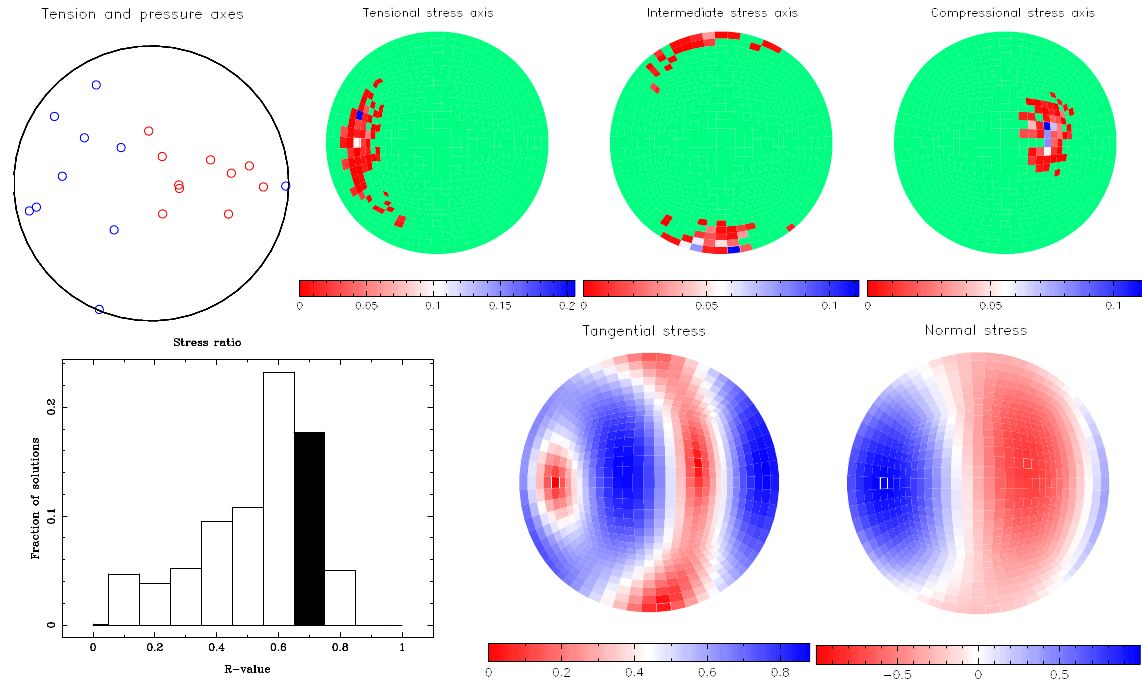
Fig. A3. Results of stress inversion for cluster of shallow earthquakes in the Iraklion basin. Explanation of subfigures is as in Fig. 5. W. Friederich et al.: Focal mechanisms and stress field in the Southern Aegean 23